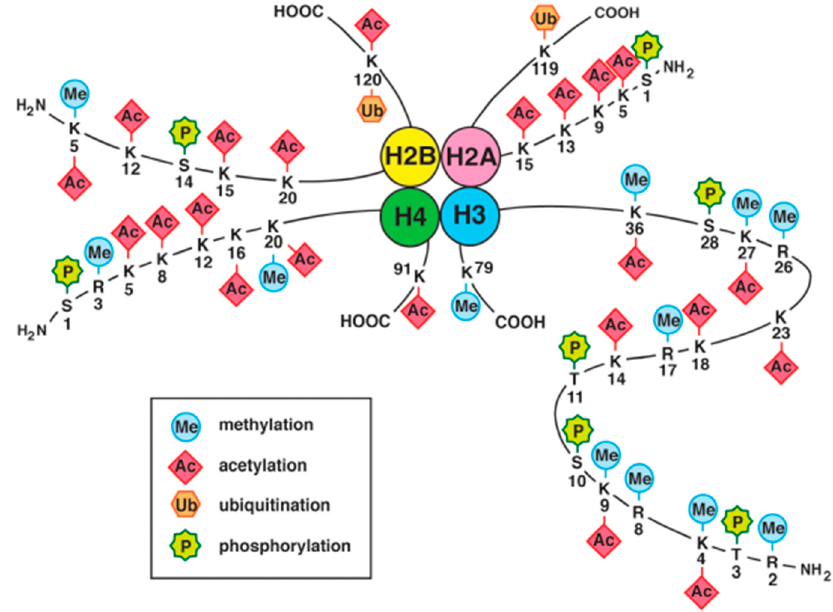
Figure 2. Histone modifications, including methylation, acetylation, ubiquitination, phosphorylation, and sumoylation have a variety of biological functions, including the regulation of chromatin states and gene transcription.